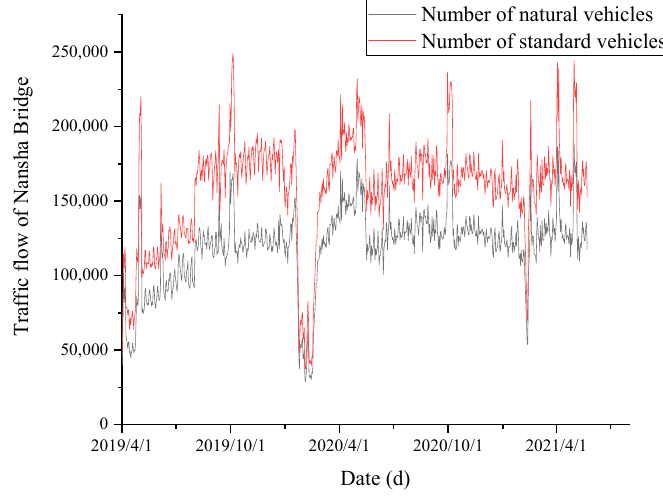
Figure 4. Nansha Bridge traffic volumes.